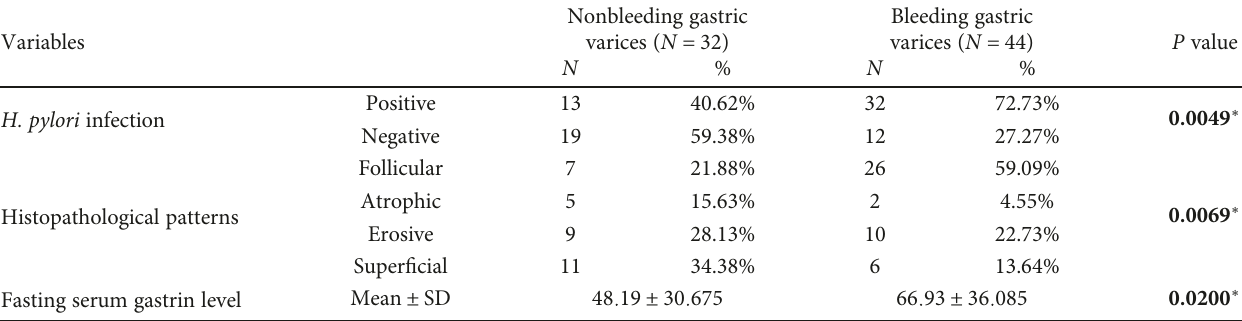
Table 2: Prevalence of H. pylori infection, histopathological patterns of chronic gastritis, and the fasting serum gastrin level among the studied